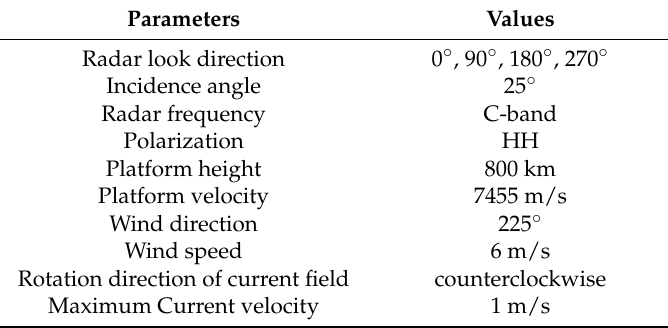
Figure 12. Simulated SAR eddy images under different radar look directions. ( a – d ) correspond to the look directions of 0°, 90°, 180°, and 270° respectively. The black arrow represents the wind direction and the blue arrow indicates the rotation direction of the current field. Table 5. The simulation parameters of Figure